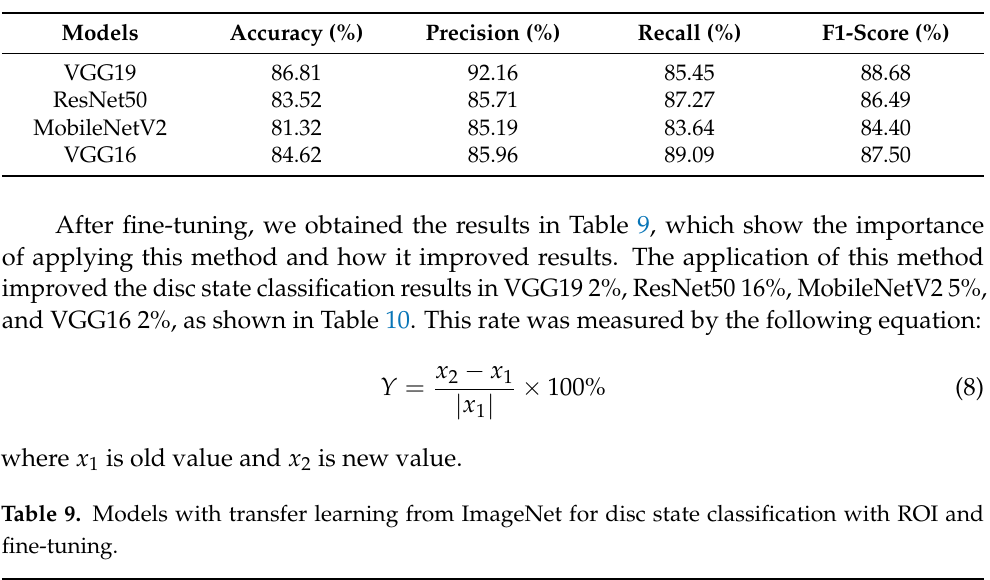
Table 8. Models with transfer learning from ImageNet for disc state classification with ROI and without fine-tuning.